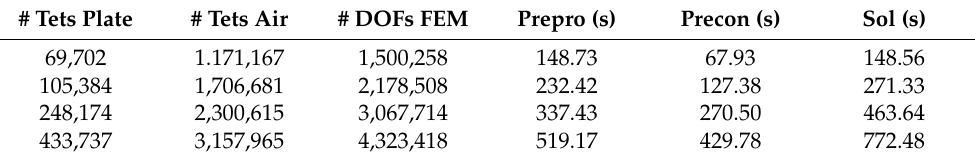
Table 13. Computation times for first ord. FEM software implementing the A , V - A formulation